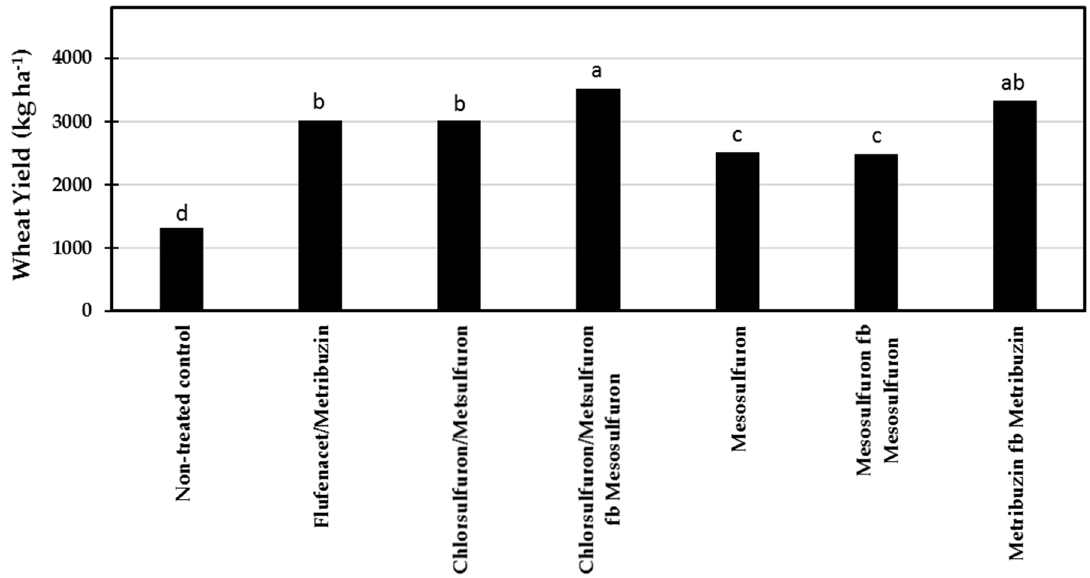
Figure 2. Wheat yield as affected by herbicide treatments in 2005–2006. Similar letter on bars indicates no statistical difference at p ≤ 0.05. fb means followed by.